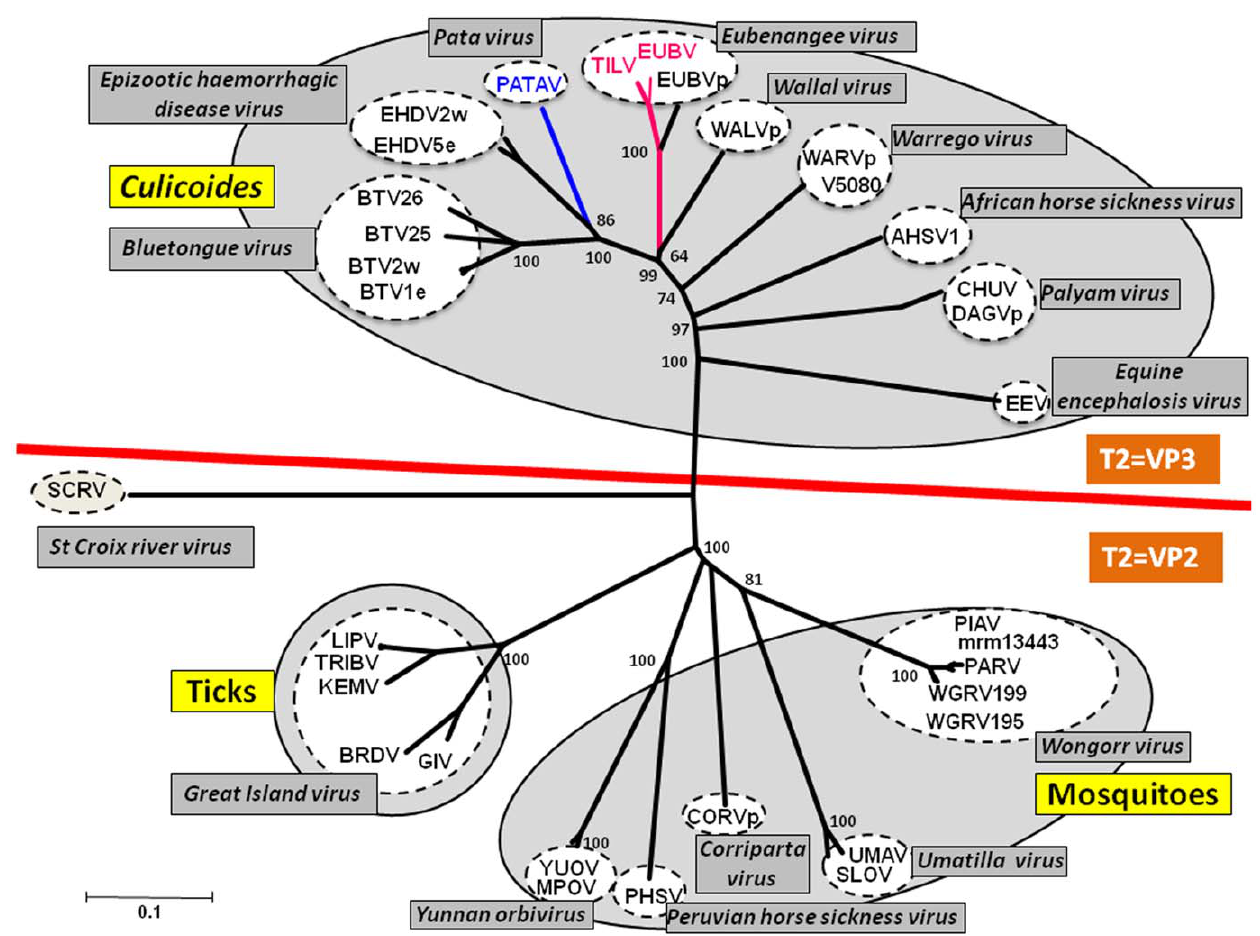
Figure 2. Unrooted Neighbour-joining tree comparing orbivirus T2 protein sequences. The tree was constructed using distance matrices, generated using the p-distance determination algorithm in MEGA 5 (1000 bootstrap replicates) [58]. Since many of the available sequences are incomplete, the analysis is based on partial sequences (aa 393 to 548, numbered with reference to the aa sequence of BTV VP3 (T2)). The numbers at nodes indicate bootstrap confidence values after 1000 replications. The tree shown in Figure 3 was drawn using same parameters. The EUBV and TILV isolates characterised in this study are shown in red font and PATAV is shown in blue font. Full names of virus isolates and accession numbers of T2 protein sequences used for comparative analysis are listed in Table S1 (supplementary data). ‘e’ and ‘w’ after serotype number indicate eastern and western strains, respectively.